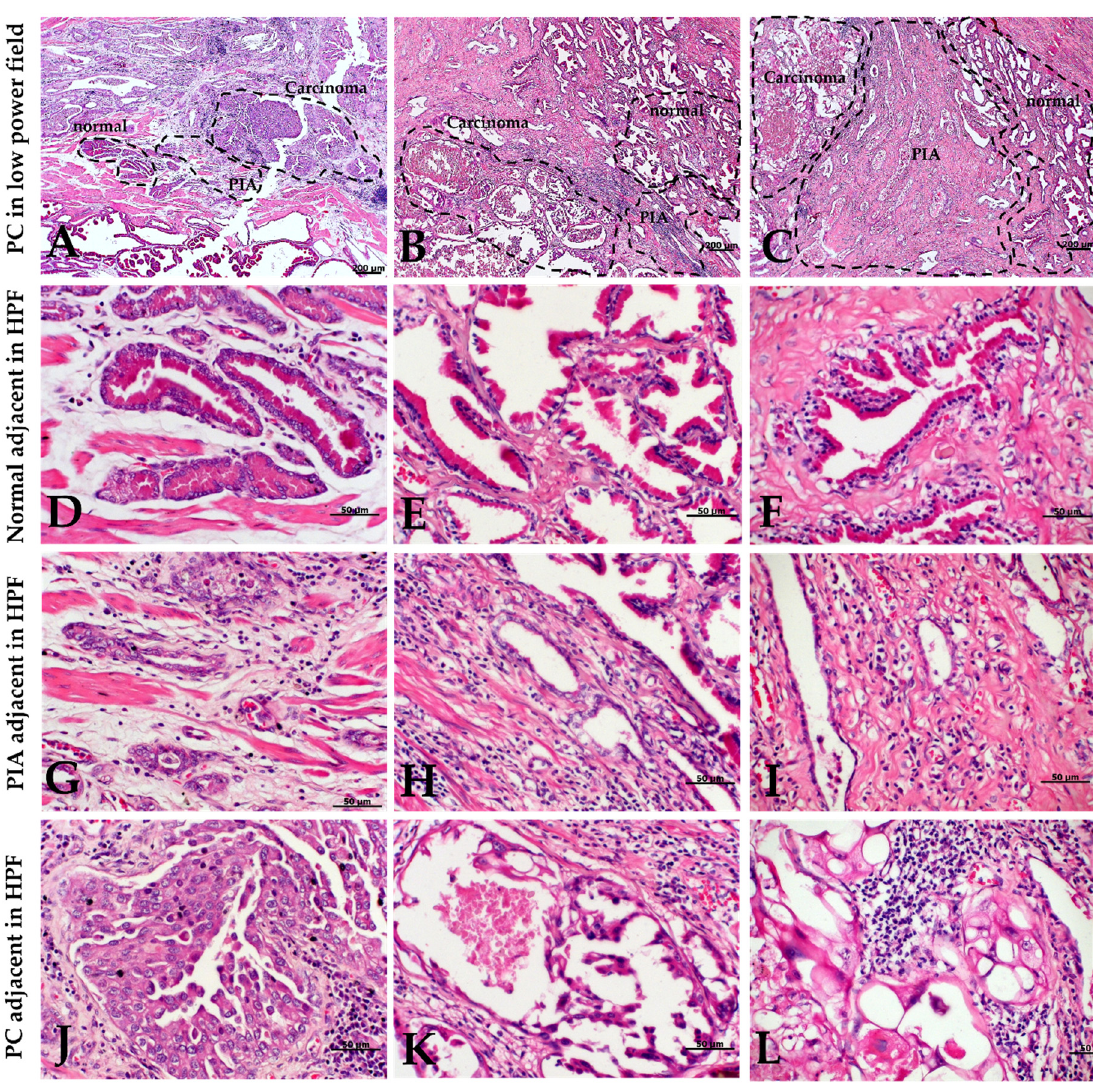
Figure 3. Hematoxylin and eosin (H&E) staining from three different canine prostate carcinomas (PC). ( A – C ): Low power field containing a carcinoma area surrounded by PIA and a normal adjacent area. A clear morphological transition between normal, proliferative inflammatory atrophy (PIA) and PC areas is evident. ( D – F ): High power field (inset of figures ( A – C ), respectively) of adjacent normal tissue. Note the prostatic gland epithelium consisting of columnar and basal epithelial cells. ( G – I ): High power field of surrounding PIA (areas outlined by the plotted areas in figures ( A – C )). Characteristic simple atrophy with one epithelial layer and hyperchromatic nuclei. ( J – L ): High power field of a carcinoma area. ( J ): Neoplastic cells disposed in nests and moderate pleomorphism. ( K ): Cells present a pseudopapillary shape with presence of degeneration. ( L ): Ballooning neoplastic cells showing degeneration associated intense surrounding inflammation. HPF: High power field.